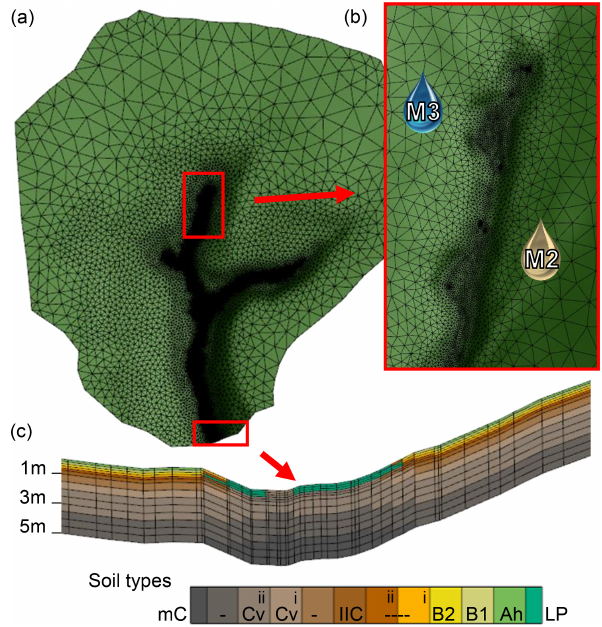
Figure 2. Set-up of the model mesh (a) with a zoom on the fine horizontal resolution in the riparian areas and the streambed (b) and a vertical cross section through the stream valley and ad- jacent hillslopes (c) showing the vertical discretisation and as- signment of different soil properties (cf. Table 1). LP = riparian Leptosol, Ah = topsoil, B1 and B2 = subsoil, IIC = basal layer, Cv = fractured bedrock, mC = fresh